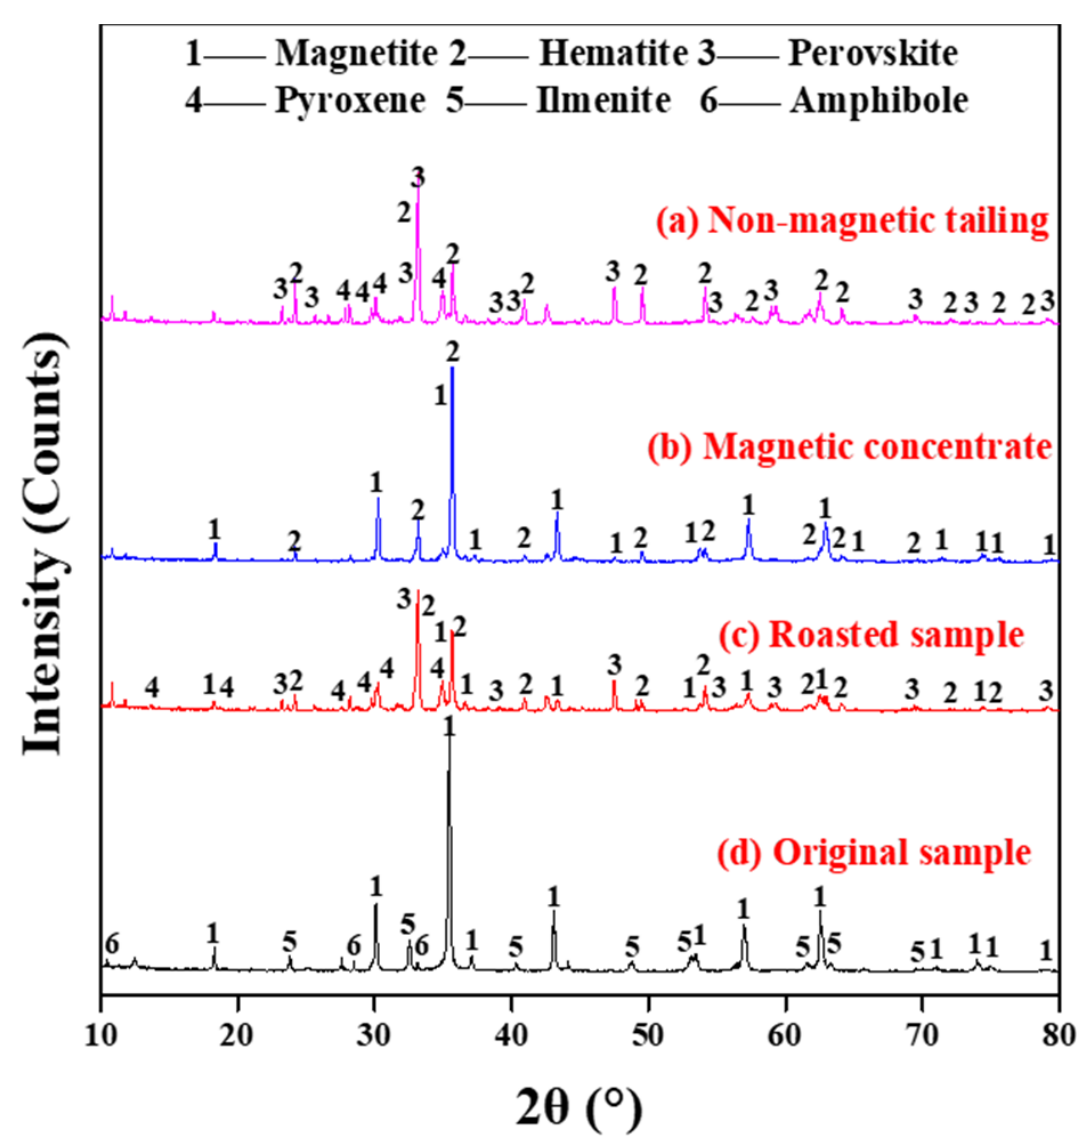
Figure 2. XRD spectrum of the non-magnetic tailing ( a ), magnetic concentrate ( b ), roasted sample ( c ) and original sample ( d ).